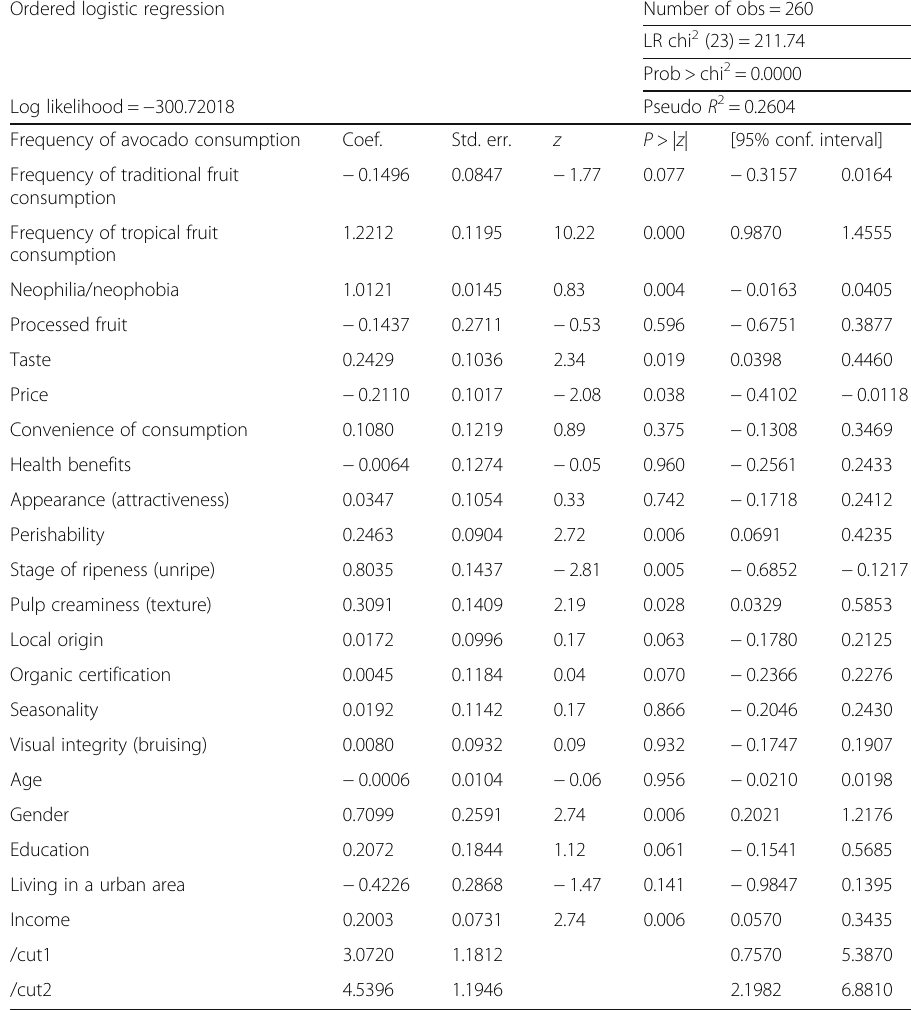
LR chi 2 (23) = 211.74 Prob > chi 2 = 0.0000